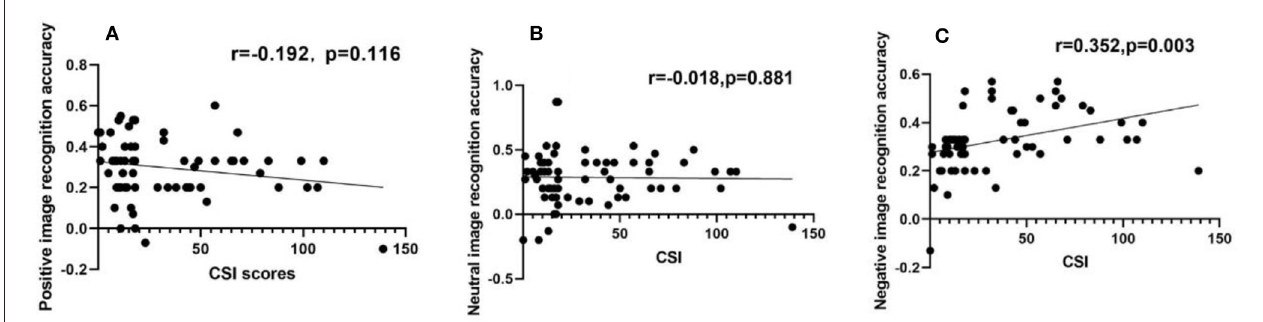
FIGURE 3 | Negative image recognition accuracy had a positive correlation with CSI scores, while positive or neutral image recognition accuracy had no relation with CSI scores, respectively. (A–C) Scatter diagram for the recognition accuracy of positive image (A) , neutral image (B) , and negative image (C) , showing that positive or neutral image recognition accuracy had no relation with CSI score (A,B) , but there was a positive correlation between negative image recognition accuracy and CSI score (C) .